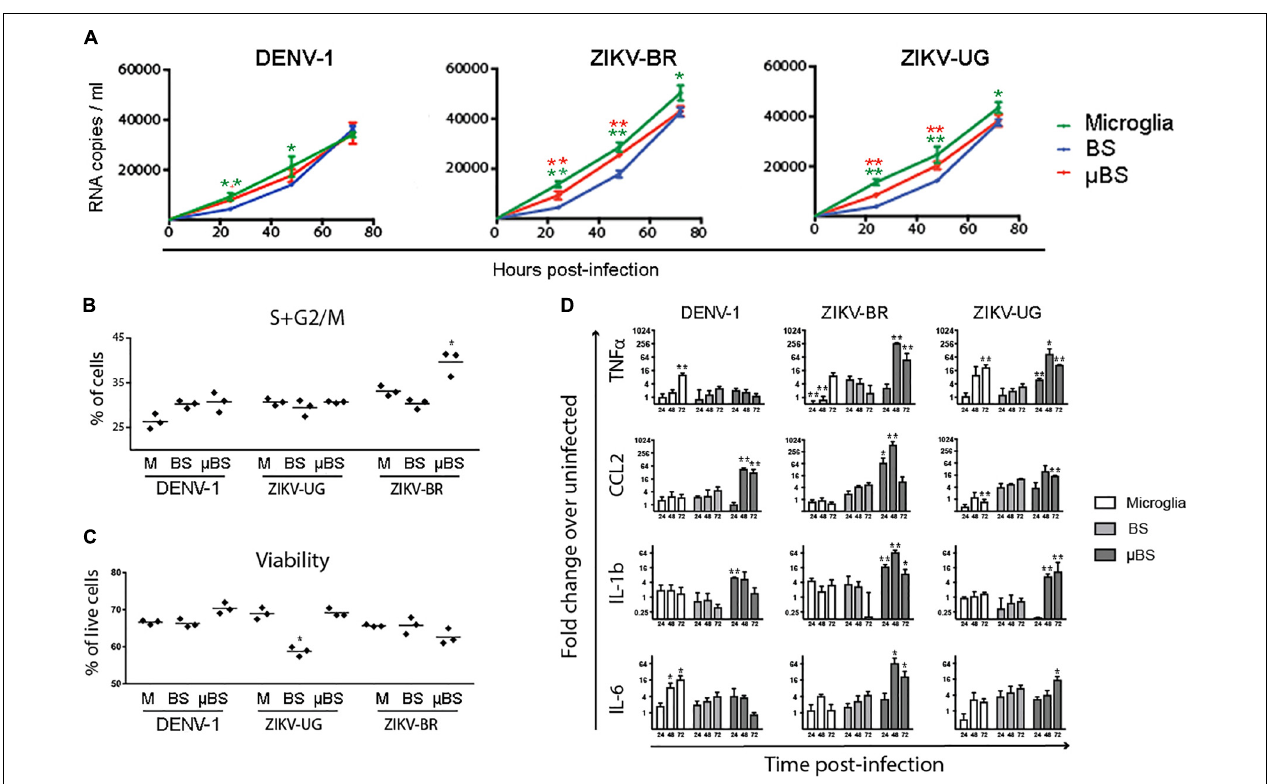
FIGURE 4 | Effects of Flavivirus infection on 3D human iPSC-derived brain spheres (BrainSpheres, BS) without or with microglia cells ( µ BS). The microglia cells, BS, and µ BS were infected with Dengue, ZIKV-BR, and ZIKV-UG using MOI equal 0.1. (A) shows the growth kinetics of flaviviruses over time for the three models. The viral load (RNA copies/mL) are shown with standard deviation. (B) Changes in cell cycle shown as percentage of cells in G2/S phase in BS, µ BS, and microglia treated or non-treated with the different viruses. (C) Annexin V Apoptosis Muse assay results. Results represent % live cells in BS, µ BS, and microglia samples after the different flavivirus treatments. (D) Gene expression relative quantification for TNF α , CCL2, IL-1b , and IL-6 over the time. Statistical analysis was performed using the Dunnett’s Test ( ∗ mean equal p < 0.05 and ∗∗ p < 0.01) for two independent experiments, three biological replicates on each